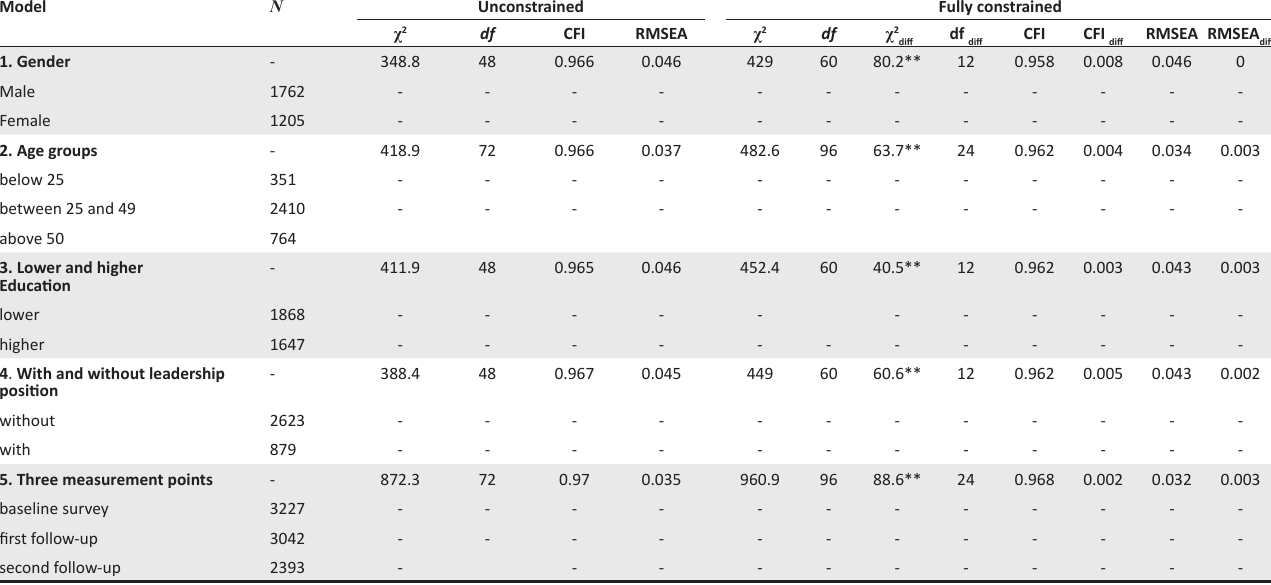
TABLE 1: Invariance of Work-SoC across different groups and time. Model